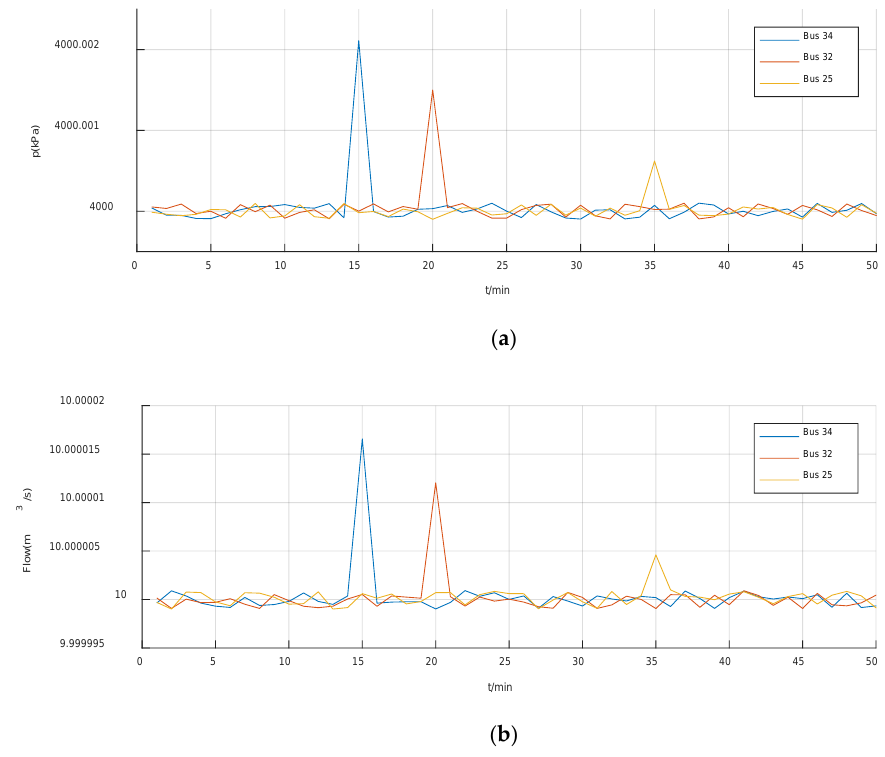
Figure 6. Pressure and flow curves of several buses: ( a ) curves of pressure fluctuation of buses; ( b ) curves of flow fluctuation of buses.